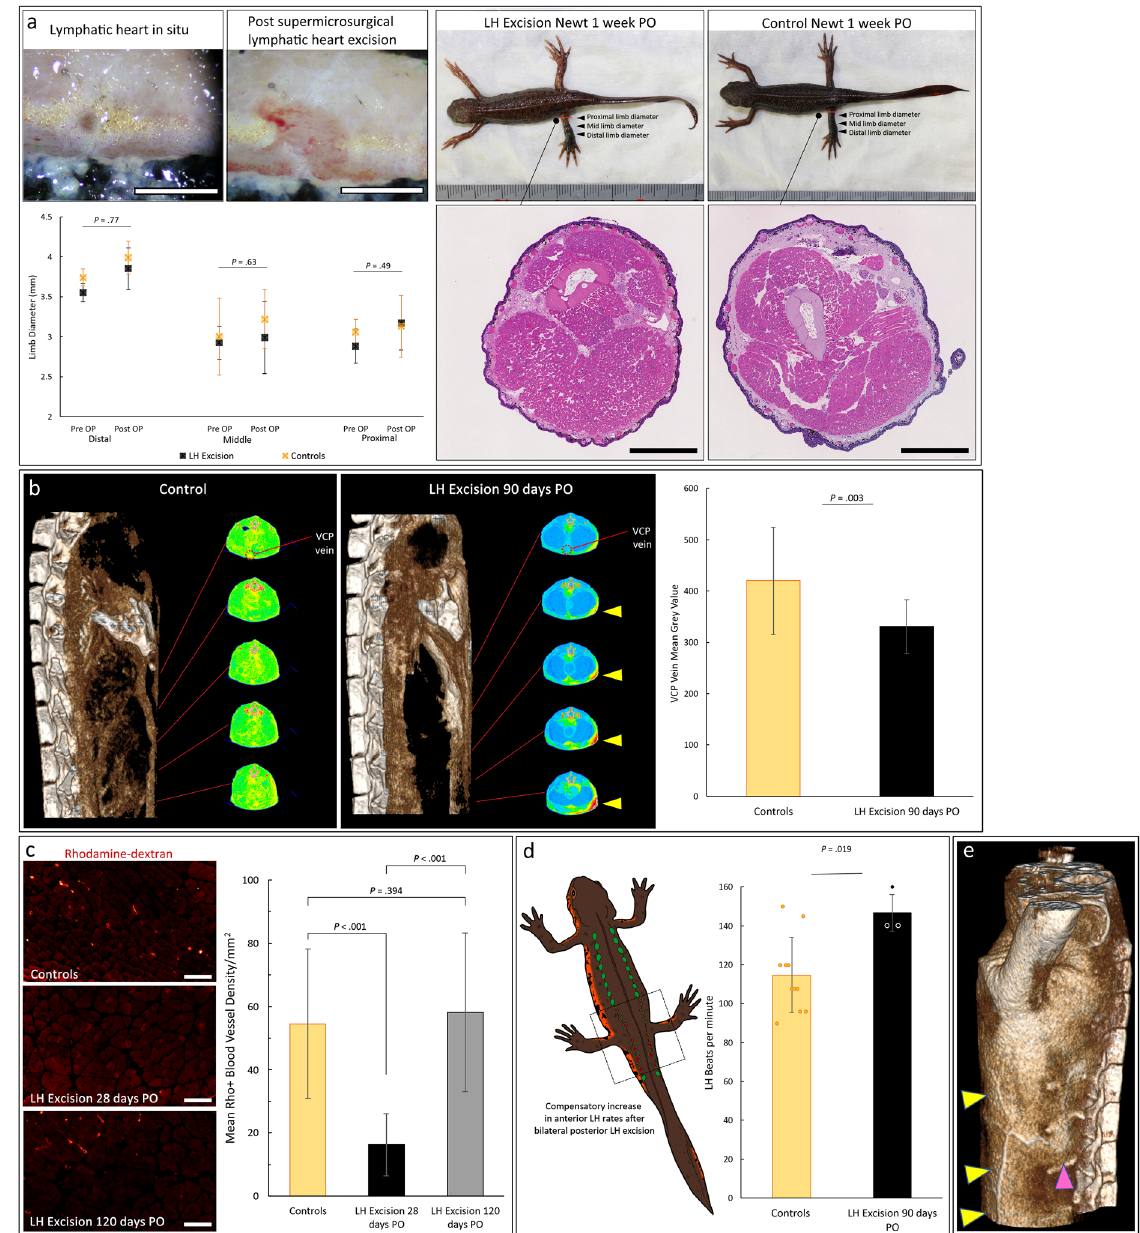
Figure 5. Physiological changes in lymphatic circulation following lymphatic heart excision. ( a ) Lymphatic hearts (LH) excision in newts did not cause edema, histological changes, nor death (Scale bars = 1 mm). There was no significant difference in the 1-week post operative (PO) limb diameters (proximal t(9) = 0.729, p = 0.485, middle t(9) = − 0.504, p = 0.627, distal t(9) = 0.297, p = 0.773) between LH excision newts and controls with good inter-rater reliability ICC = 0.893, 95% CI (0.825, 0.934). ( b ) Micro-CT lymphangiography showed reduced lymphatic contrast in the blood circulation in LH excision newts at 90 days PO, with Trunci lymphatici longitudinales parabdominales (TLyLPab) collateral flow seen (yellow arrowheads). Vena cava posterior (VCP) analysis showed LH excision newts had a significantly lower mean grey value (t(34) = − 3.156, p = 0.003) than controls. ( c ) Rhodamine-dextran fluorescence lymphangiography analysis of lymphatics to vein flow (Scale bars = 100 μm) also showed a significant decrease in the density of blood vessels receiving lymphatic fluid (t(188) = 13.057, p < 0.001) at 28 days post excision of all the LHs but this returned to normal at 120 days PO (t(161) = − 0.854, p = 0.394). ( d ) Ultra-high frequency ultrasonography showed a significant increase (t(12) = − 2.707, p = 0.019) in the LH rate in newts that had bilateral posterior LH excision. ( e ) Collateral flow maintained lymphatic circulation after excision of LHs. TLyLPab collateral is shown (yellow arrowheads) with connections to the TvIL (magenta arrowhead). These results confirmed that LH excision successfully terminated peripheral lymphatic to vein flow for 90 days following which normal lymphatic to vein flow was restored by 120 days PO. Data represent mean ± standard deviation (error